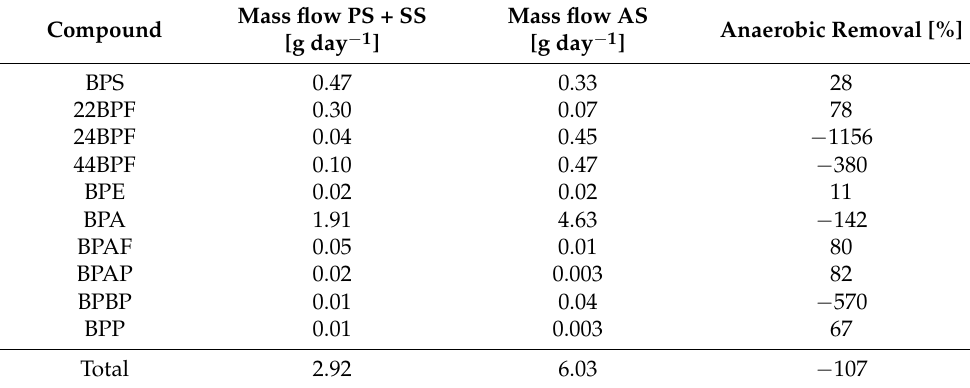
Table 2. Mass flows of BPs in sludge and their